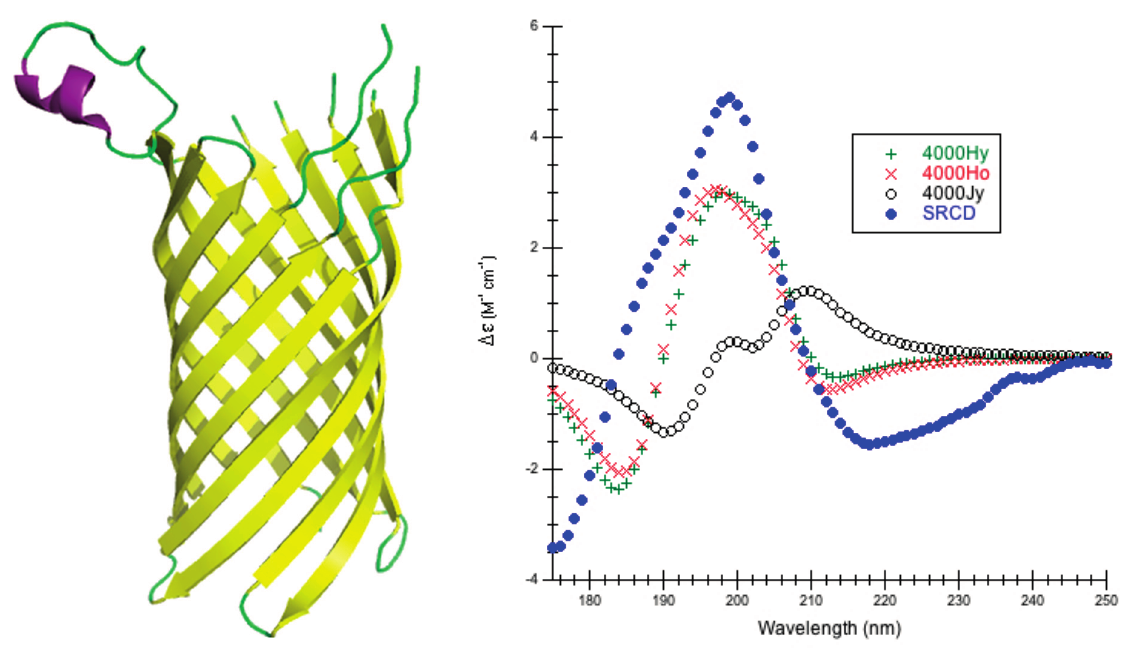
Figure 3. Outer Membrane Protein OPCA. ( Left ) Secondary structure of outer